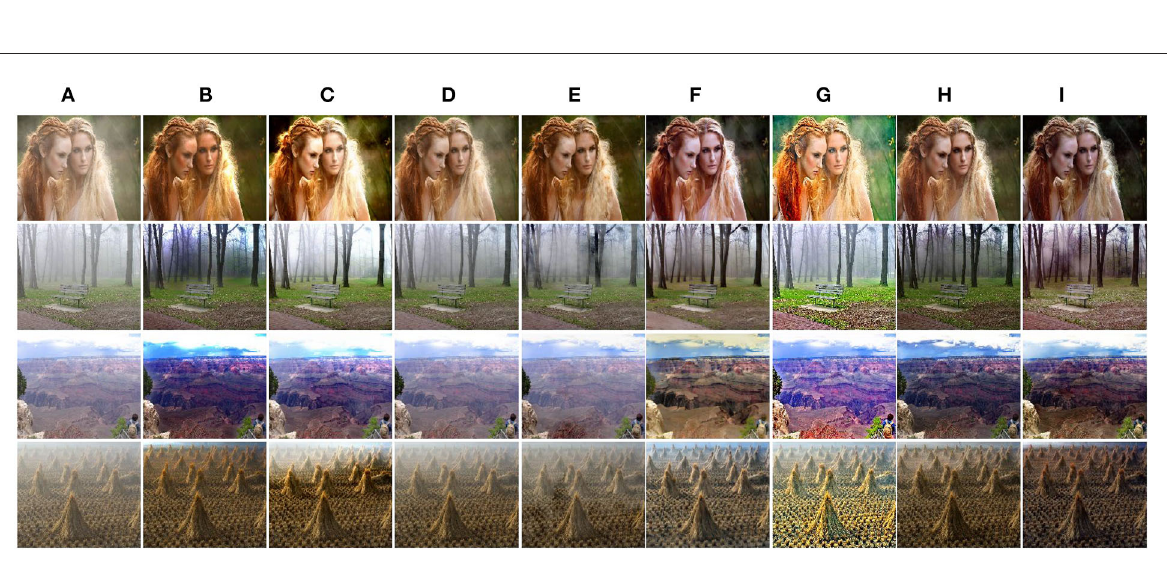
C, the proposed method without the guidance of J mod , Variant D, the proposed method without the guidance of J free , and Variant E, the proposed PMGSDN. We train